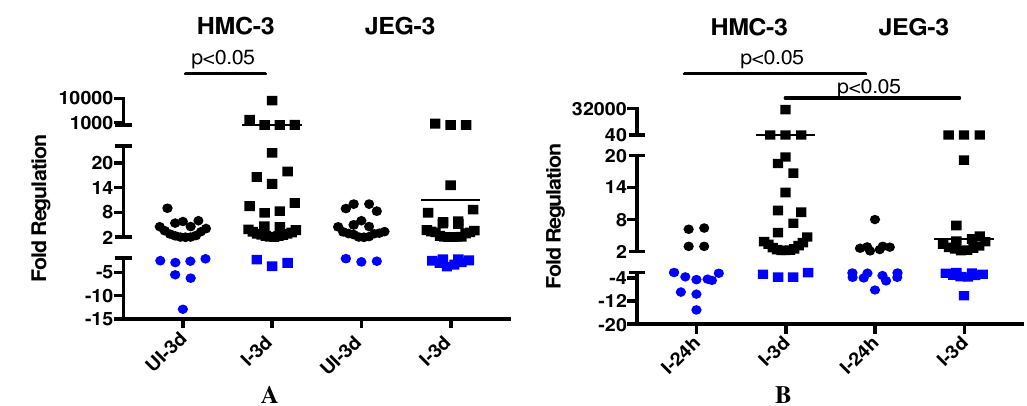
Figure 2. Results from an intracellular innate immune response RT-qPCR array. Each circle or square represents an individual gene that was either upregulated (black) or downregulated (blue). ( A ) Differentially expressed genes at one dpi versus three dpi in human microglia and placenta cells. ( B ) Differentially expressed genes of ZIKV-infected (I) samples versus time-matched mock-infected (UI) samples at 24 h and three days post infection with ZIKV. The numerical values on the Y-axis have been collapsed in regions that had no differentially expressed genes in order to improve visibility.